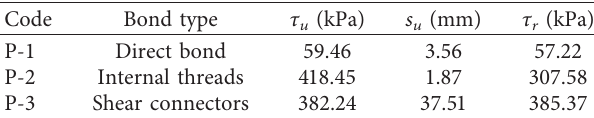
Figure 4: Number and position of strain gauges of specimens with different lengths. (a) 100 mm. (b) 200 mm. (c) 400mm. (d) 800mm. Table 4: Test results of specimens P-1, P-2, and P-3.